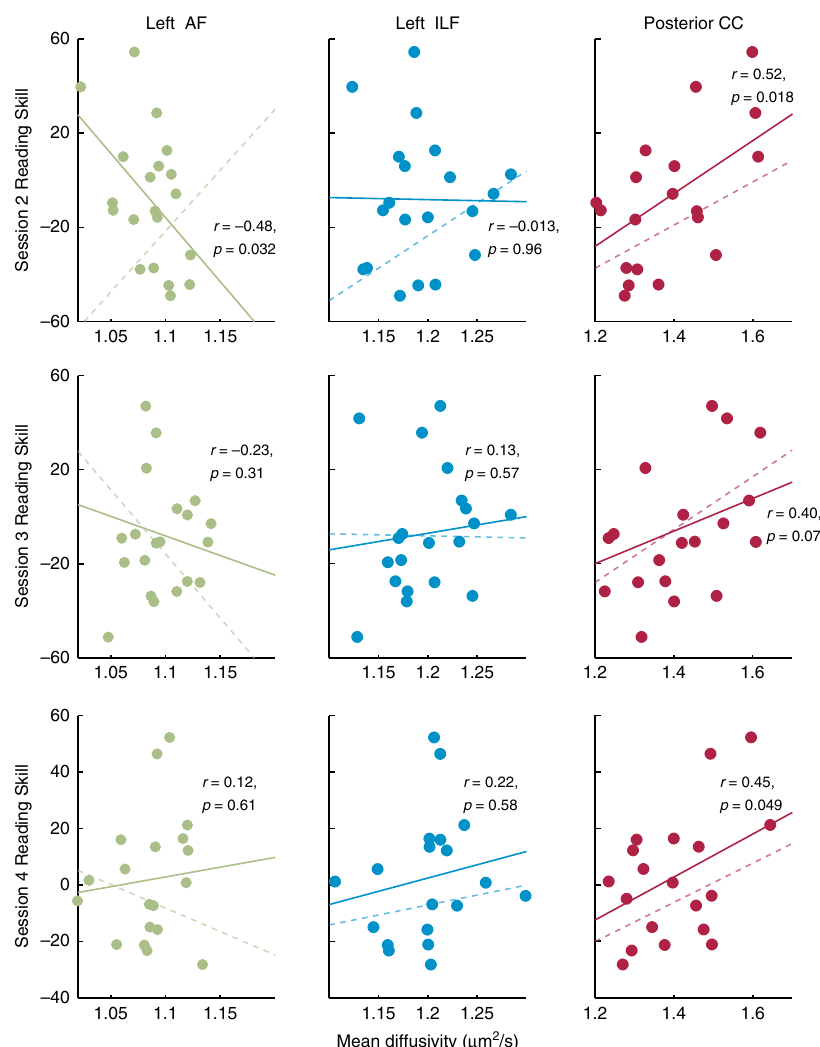
Fig. 4 Correlations between white matter properties and reading skill change during learning. Plots show the cross-sectional correlation for sessions 2 – 4 (top to bottom) for each tract for the intervention group. A solid best- fi t line is plotted for each session. A dashed line in each panel represents the best- fi t line for the preceding session (session n − 1) to illustrate the session-to-session changes. For the AF and ILF, correlations change in size and/or